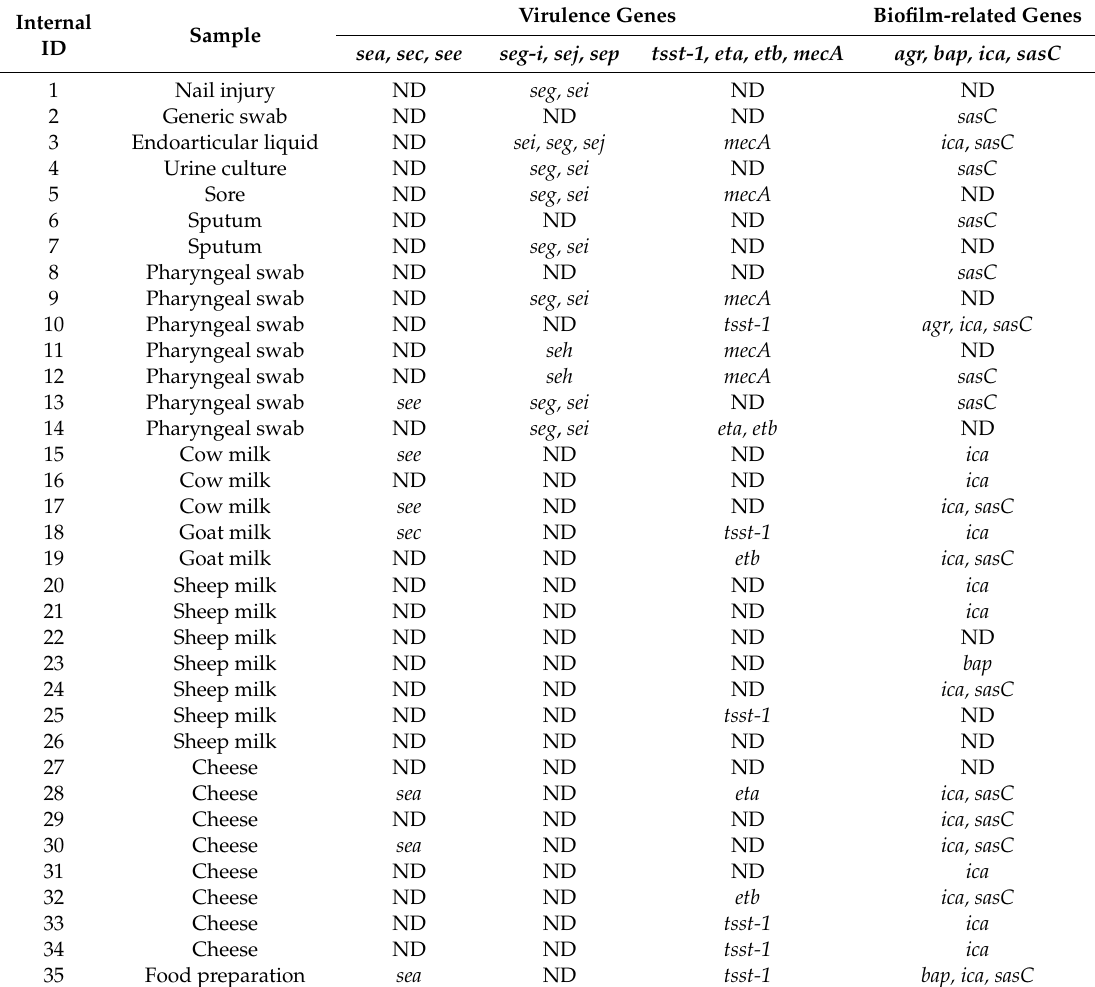
Table 4. Presence of the antibiotic resistance mecA gene, virulence ( sea-sep, tsst-1, eta, and etb ) and biofilm-related ( agr , bap , ica , sasC ) genes. ND indicates the analyzed genes were not detected with the used